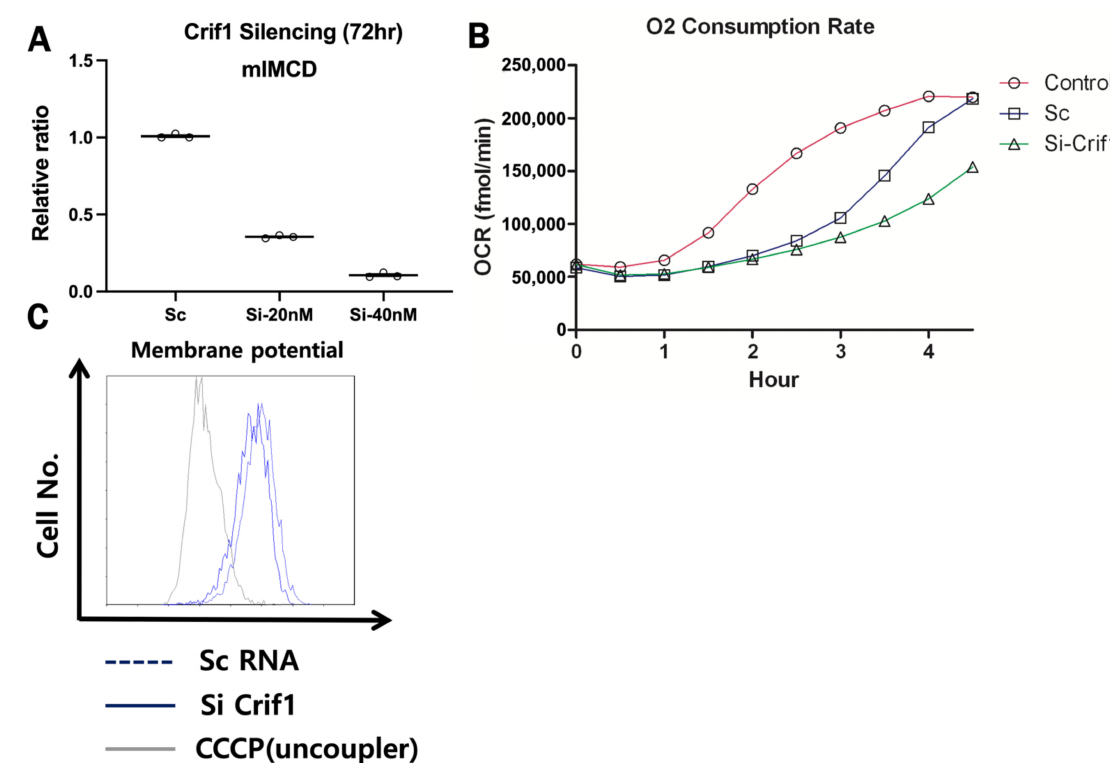
Figure 3. Representative mRNA expression of CR6-interacting factor-1 (CRIF1) in mIMCD cells ( A ). CRIF1 mRNA expression is decreased with silencing RNA treatment. O2 consumption and membrane potential are significantly decreased in Si-CRIF1-treated mIMCD cells compared with sc-treated and control mIMCD cells ( B , C ).